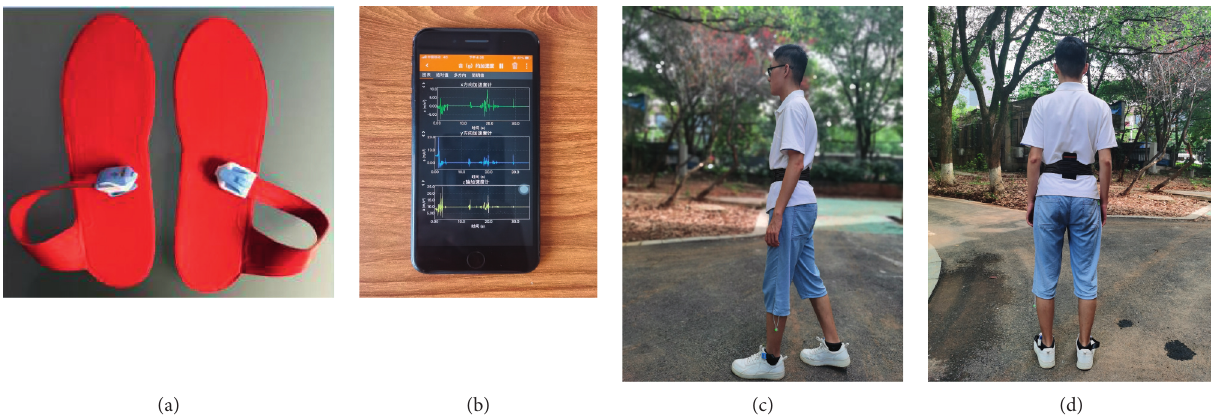
Figure 15: Test instruments and test scenario: (a) wireless pressure insoles; (b) smartphone; (c) and (d) installation of test instruments.